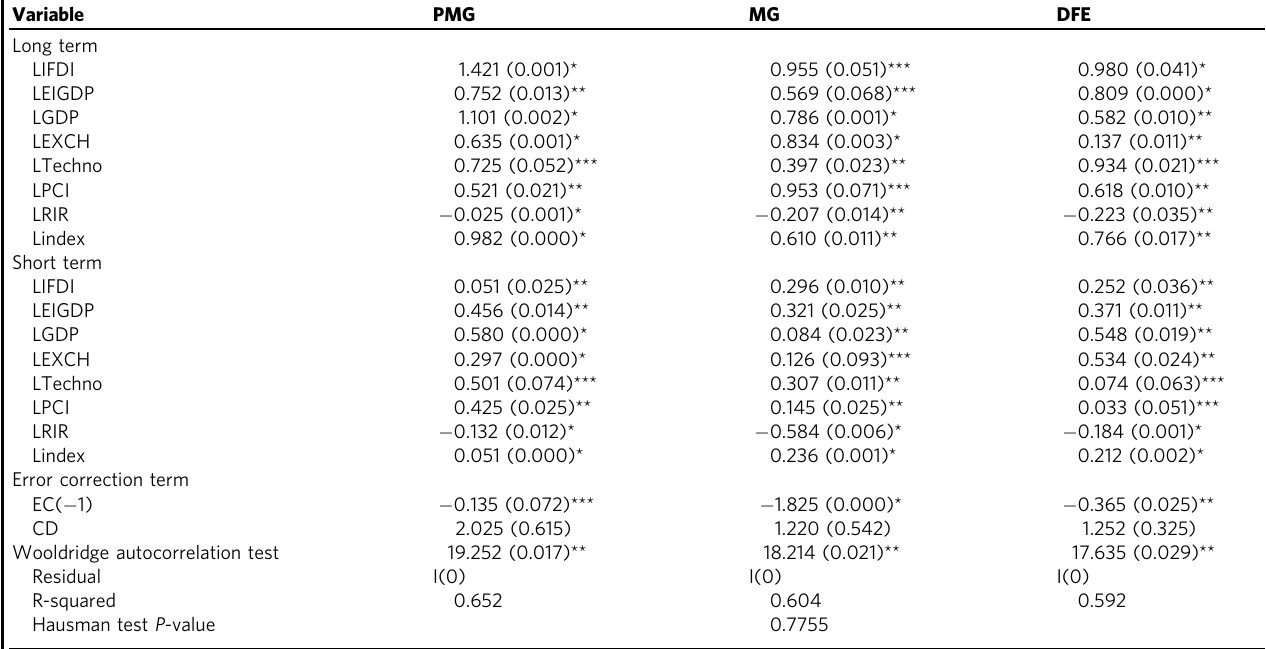
Table 6 PARDL model results.